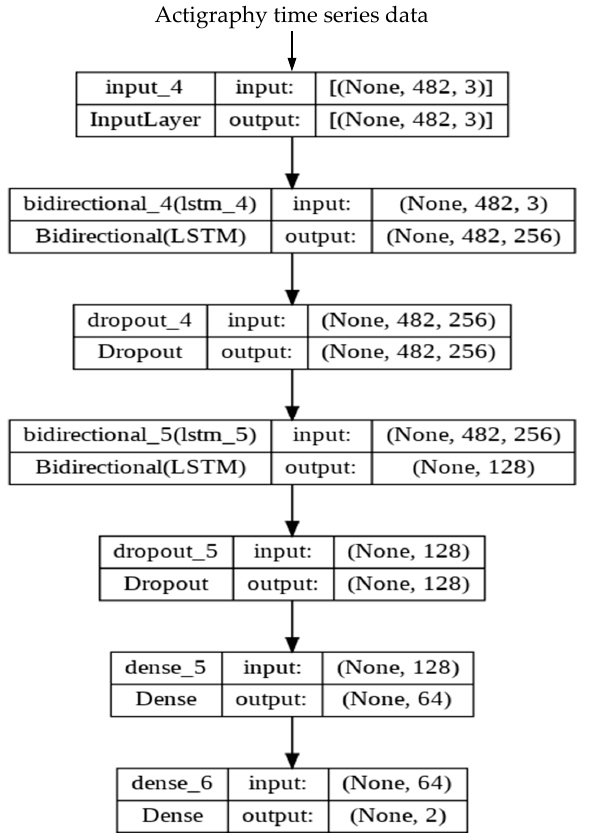
Figure A5. Configuration of BILSTM model used for experiment with only time series data.